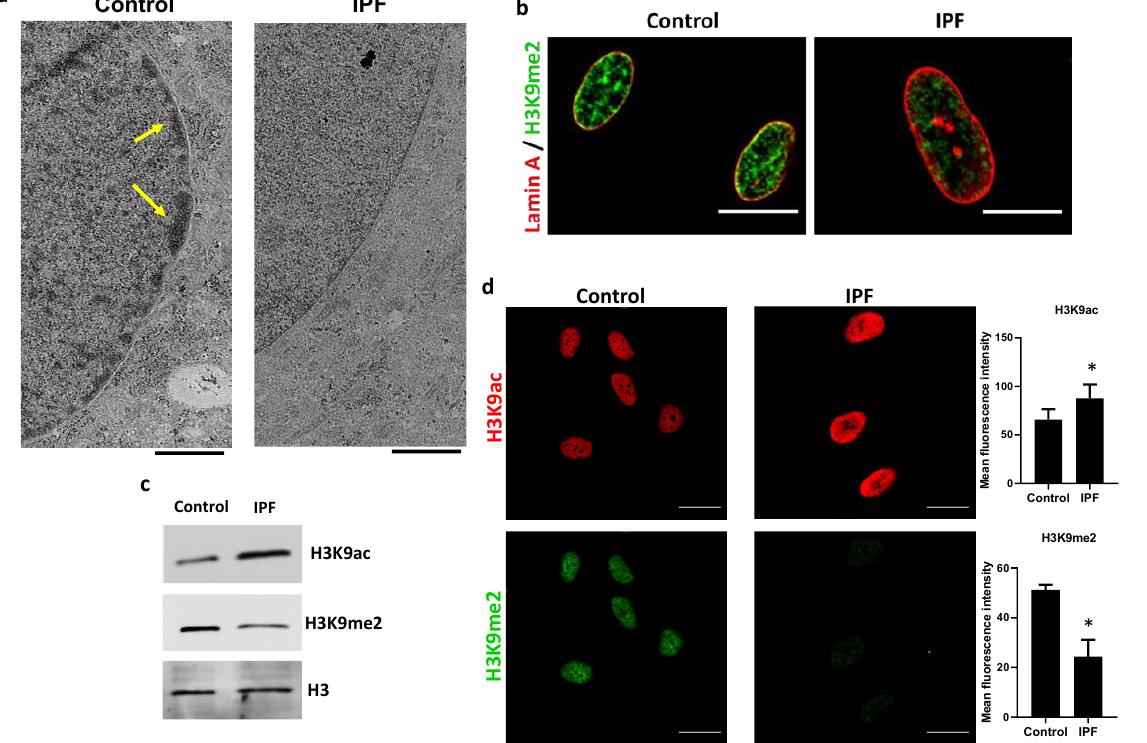
Figure 2. Reduction in peripheral heterochromatin and increase in acetylation mark (H3K9ac) in IPF fibroblasts. ( a ) Representative microphotographs of transmission electron microscopy of nuclear peripheral heterochromatin associated with lamina indicated with yellow arrows; scale bar = 1 μm. ( b ) Colocalization of H3K9me2 (heterochromatin histone mark) with lamin A by confocal microscopy; scale bar = 20 μm. ( c ) Representative immunoblot of control and IPF fibroblasts with H3K9ac and H3K9me2; H3 total was used as loading control. ( d ) Representative immunofluorescence images of control and IPF fibroblasts with H3K9me2 (green) and H3K9ac (red); scale bar = 50 μm. Graphs show fluorescence intensity quantification; each bar represents the mean ± SD from three control and three IPF cell lines of two independent experiments. * p < 0.05; by Student ’s t -test.